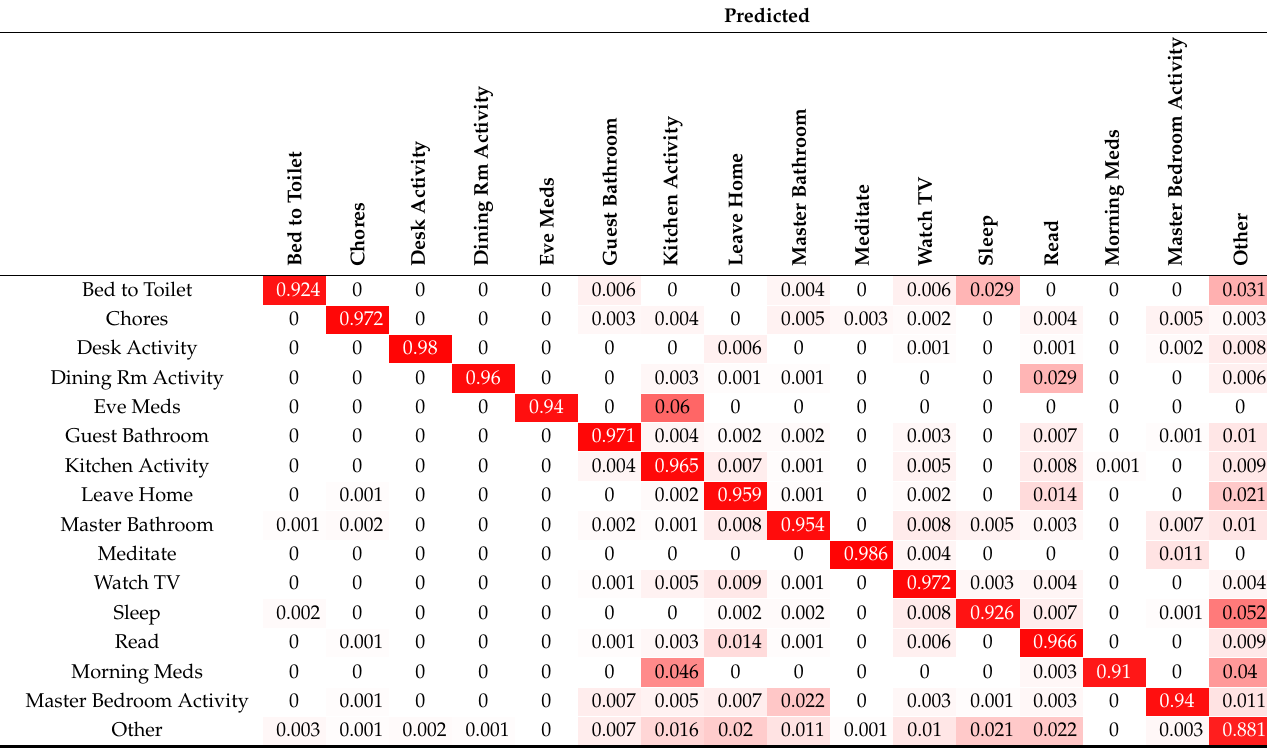
Table 4. Neural network confusion